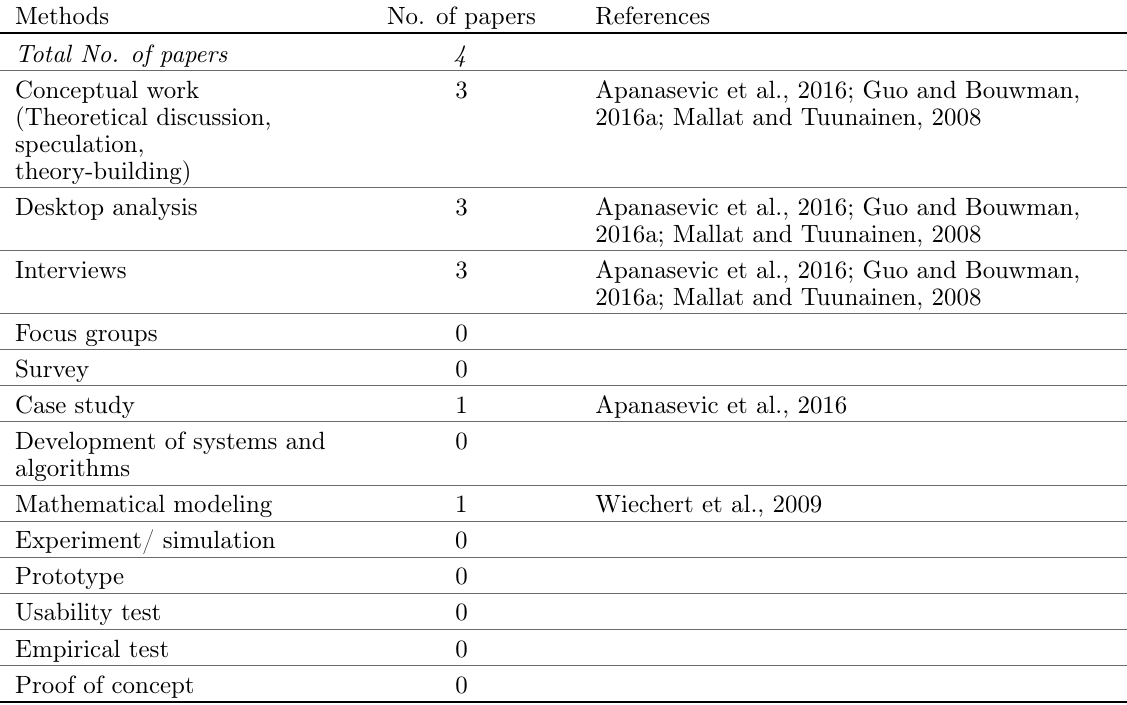
Table B.5 . Research methods used in studies on mobile payments’ merchant adoption.